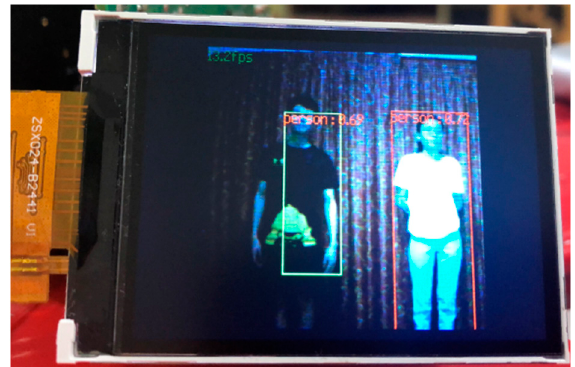
Figure 8. Pixel distance measured from the LCD of Grove AI HAT. Table 9. Constant values determined at different camera distances.